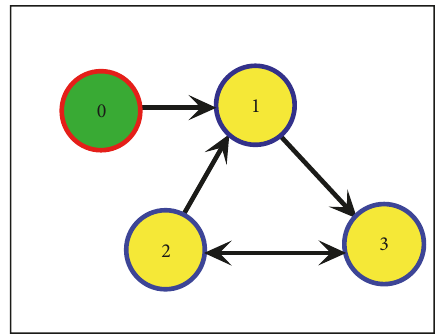
Figure 1: Communication graph among all agents. Leader: agent 0; Followers: agents 1, 2, and 3 (color